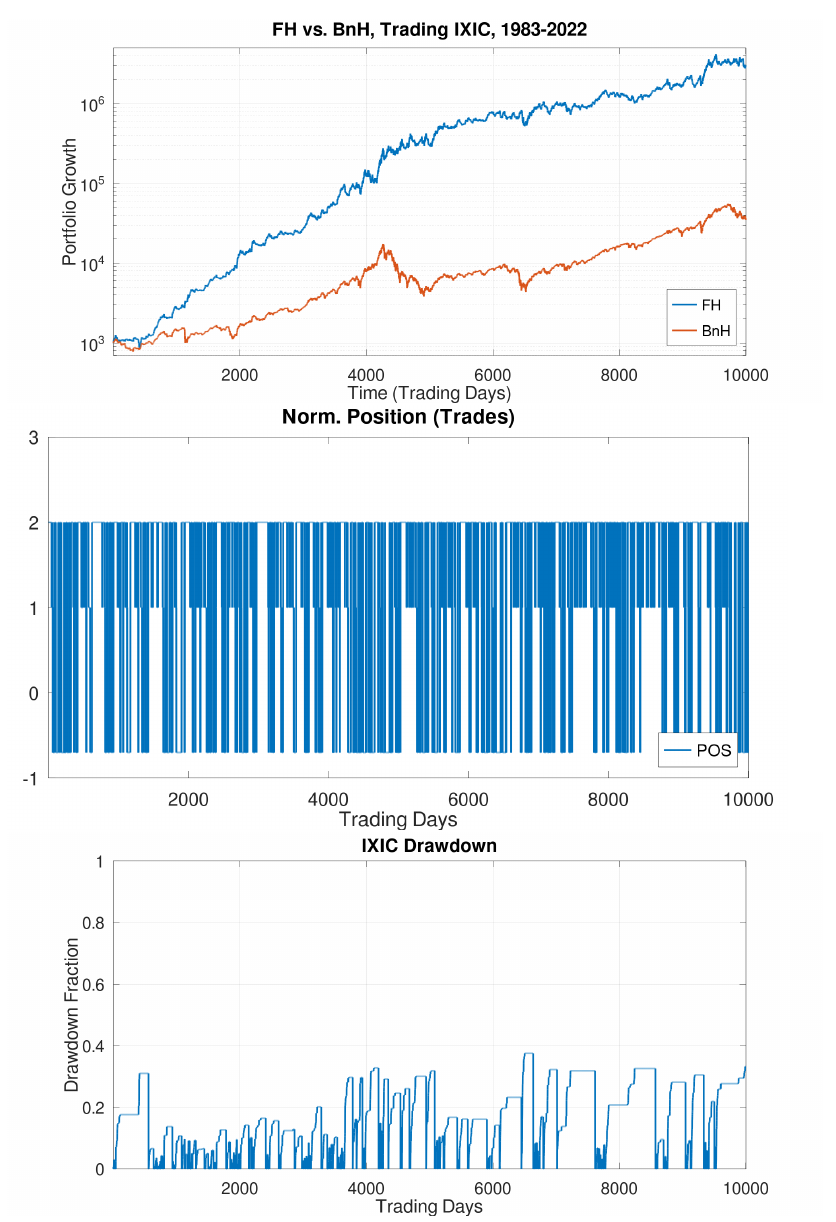
Figure 9. ( top ) The performance of a FastHedge algorithm on the Nasdaq index IXIC over a 40-year period ending 31 December 2022, compared to BnH. ( middle ) An indication of the investment position for each trading day, which shows the trades made by the system. ( bottom ) This system has robust performance, easily beating the index, while also reducing drawdowns